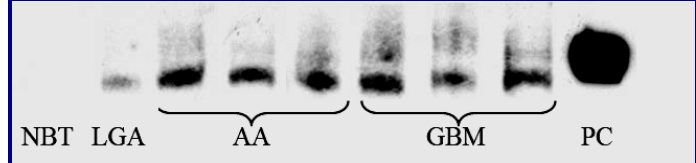
low-grade glioma; AA: anaplastic astrocytoma; GBM: glioblastoma multiform; PC: positive